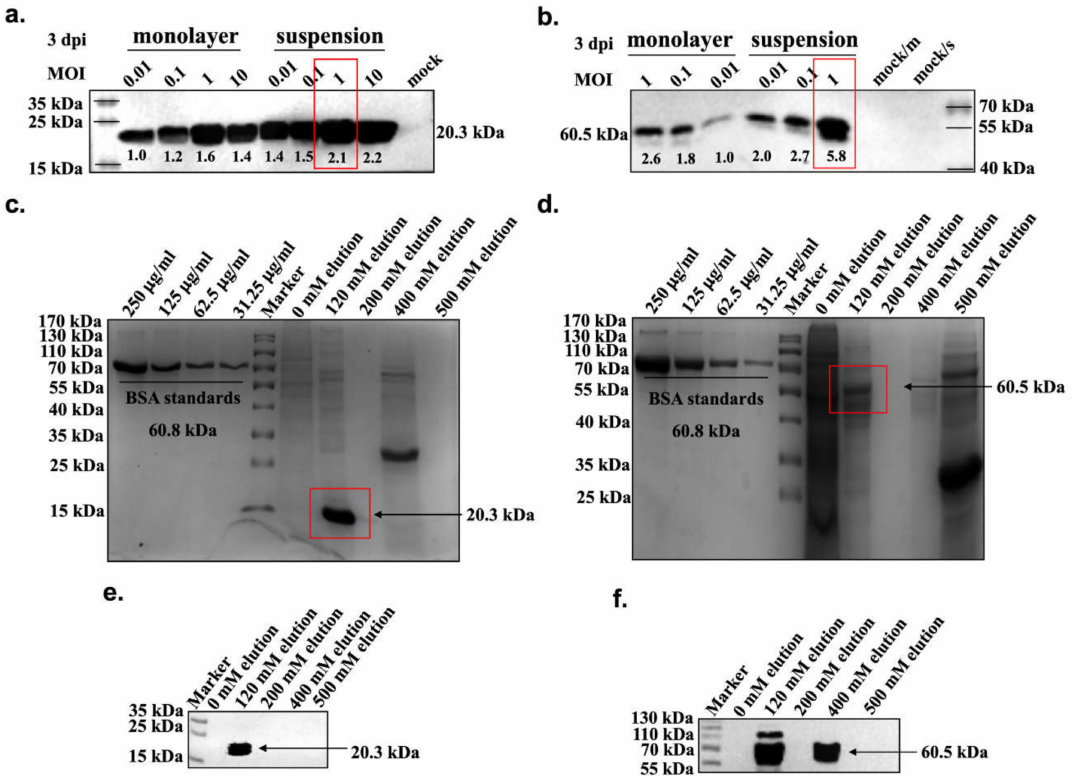
Figure 2. Amplification and purification of E2-ferritin and ferritin nanocarriers. The optimal proliferation conditions for ferritin in ( a ) and E2-ferritin in ( b ) np were both 1 MOI in suspension culture by Western blotting analysis. Protein density was measured by Image J software. The protein elution peak for ferritin in ( c ) and E2-ferritin in ( d ) were both in 120 mM imidazole by SDS-PAGE. Different concentrations of BSA were used as standard samples. The purified nanocages of ferritin in ( e ) and E2-ferritin in ( f ) were verified by immunoblotting using anti-His tag antibody. (For the uncropped blots of Figure 2a,b,e,f, see Supplementary Materials, Figures